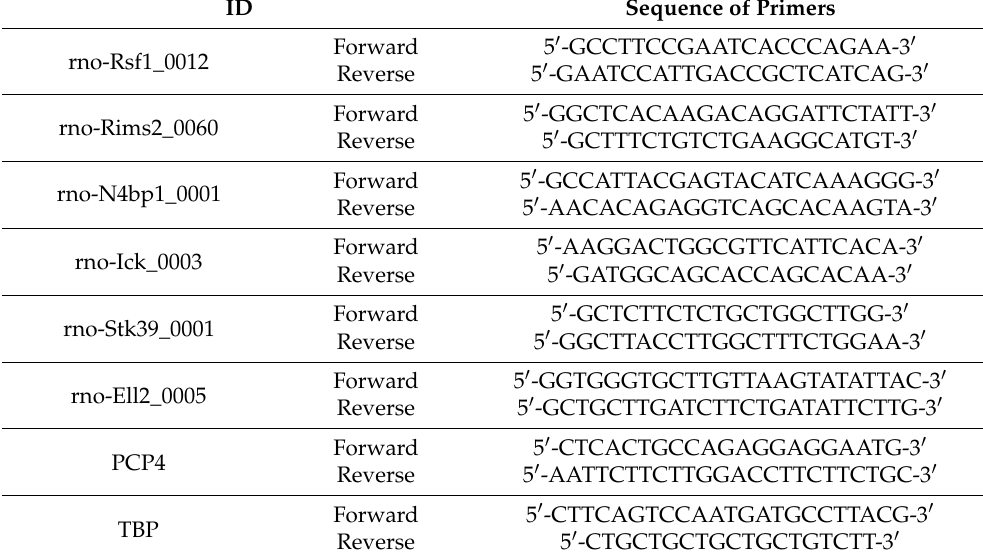
Table 1. Primer sequences used for